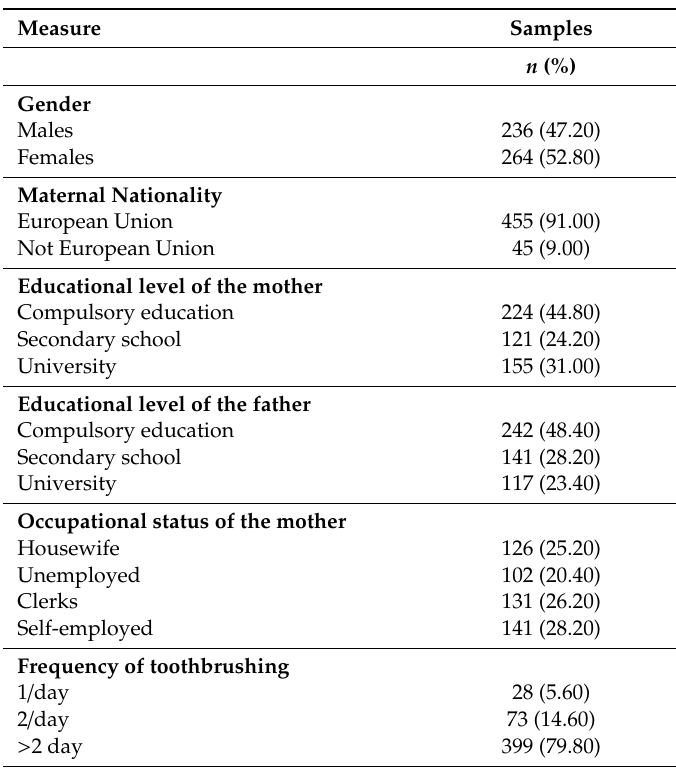
Table 2. Childrens’ socio-behavioral demographic characteristics of the sample by